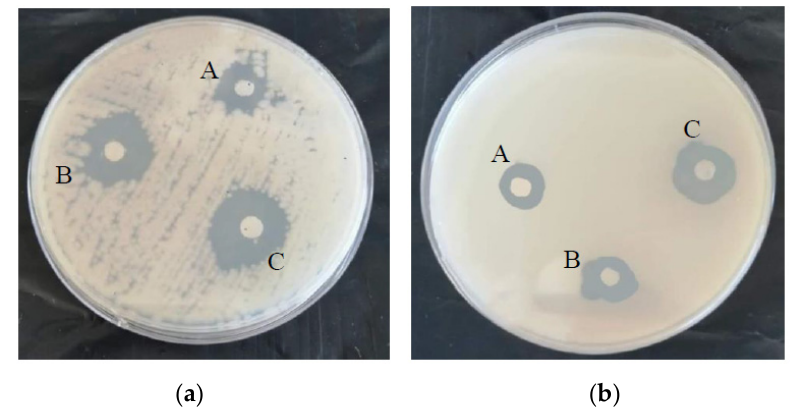
Figure 5. Antibacterial activity of essential oils in solution using agar diffusion method. A: cloves oil, B: cinnamon oil and C: oil mixture (( a ): S.aureus / ( b ): E.coli ). Table 2. Peripheral inhibition zones values (mm).